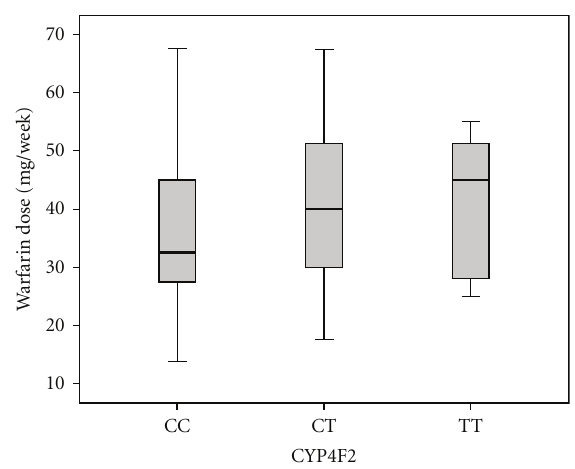
Figure 2: Box plot of mean weekly warfarin maintenance dose for combinations of di ff erent CYP4F2 genotypes. The boxes represent the values from the 25th to 75th percentile. The middle lines represent the median. The vertical lines extend from the minimum values to the maximum